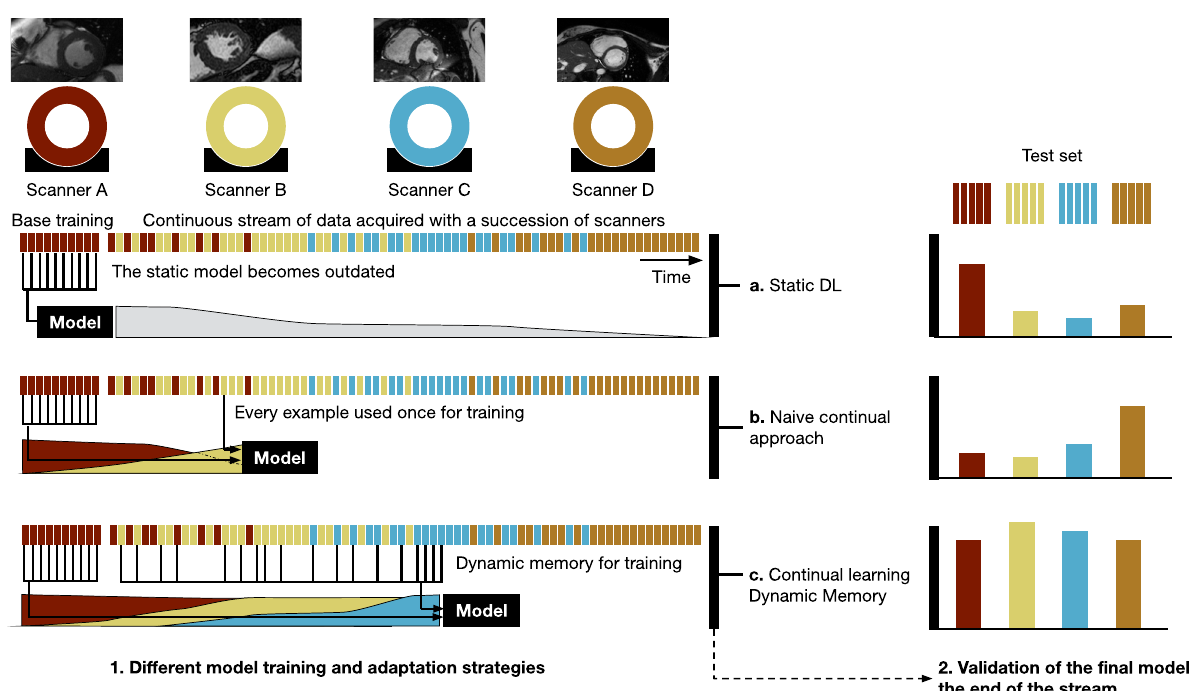
Fig. 1 Different model training and adaptation strategies. 1 Continual DL for image analysis adapts to new data properties and, at the same time, retains the capability to work with older data. a Static DL: after training and deploying a DL model, technology changes and the accuracy of the model decreases. b A naive continual learning approach to solve this limitation is to continue training a model on a stream of data. However, this leads to forgetting of old data properties, and a corresponding decrease in performance on these data. c As a continual learning approach, dynamic memory recognizes new emerging domains, and samples data in a continuous stream accordingly. The ML model adapts to new technology but stays accurate on the diverse set of scanners previously seen. This is important to ensure backward compatibility of the model and to build a more stable model that adapts to new scanners faster. 2 Validation on a separate test set evaluates the DL model performance at the end of the period. Table 1 Number of slices in data sets for both experimental